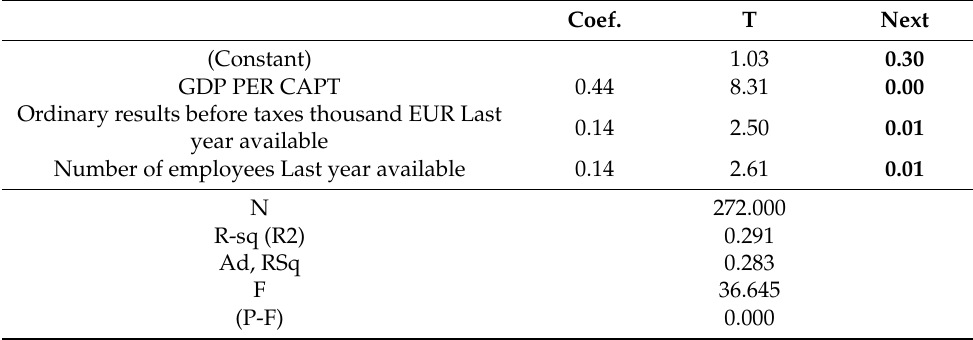
Table 11. Model B coefficients. Source: own development.